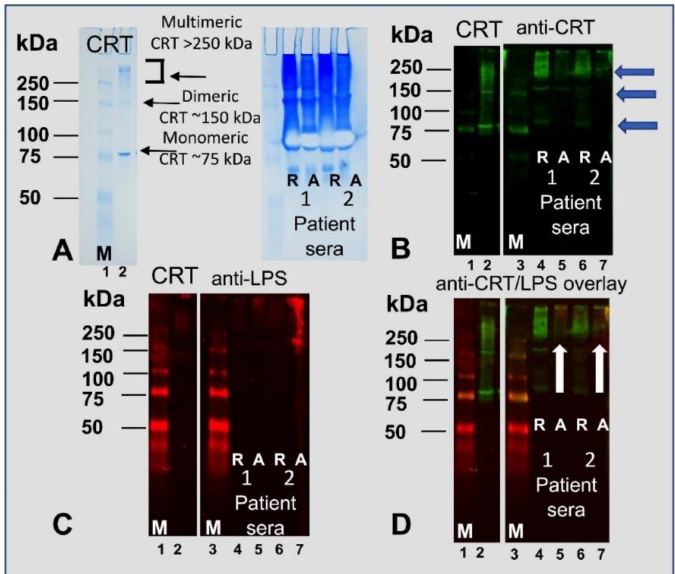
Figure 3. LPS is associated with higher molecular weight forms of calreticulin in gram-negative chronically infected bronchiectasis patients ( A ) CRT and two patient sera were run on a native PAGE gel under reducing [R] and alkylating [A] conditions and stained with Coomassie Blue and then immunoblotted with ( B ) anti-CRT (green; blue arrows depict varying molecular weight species of CRT), and ( C ) anti-LPS (red). ( D ) A double-probed immunoblot image using anti-human CRT antibody (green) and anti- E. coli LPS antibody (red) confirmed that LPS is associated with higher molecular weight aggregates of CRT. The white arrows indicate the association of LPS with CRT (yellow) in the two patient sera under alkylating conditions. Note: LPS does not bind to monomeric CRT in sera (C). The left panels in B, C and D show the immunoreactivity of the antibodies to rCRT and molecular weight markers (M, lanes 1 and 3) and rCRT in lane